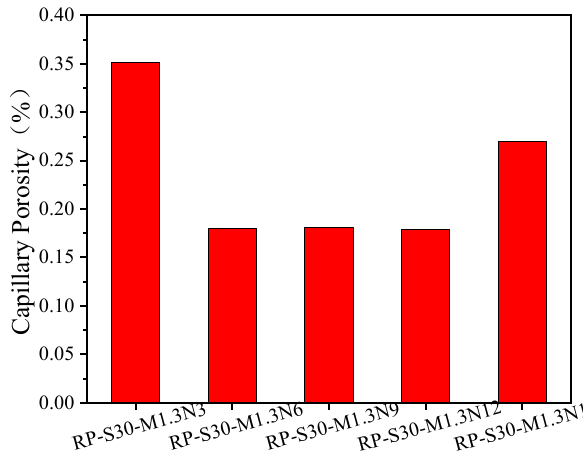
Figure 9. Capillary porosity of RPSG with different alkali equivalents.